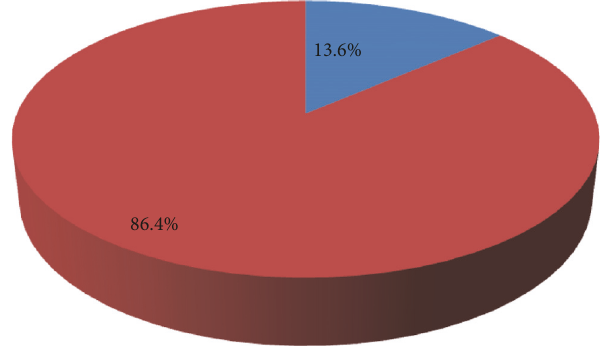
Figure 1: Prevalence of diabetic foot ulcer among adult diabetic patients in Gondar University Referral Hospital, Diabetic Clinic, 2016 ( n = 279